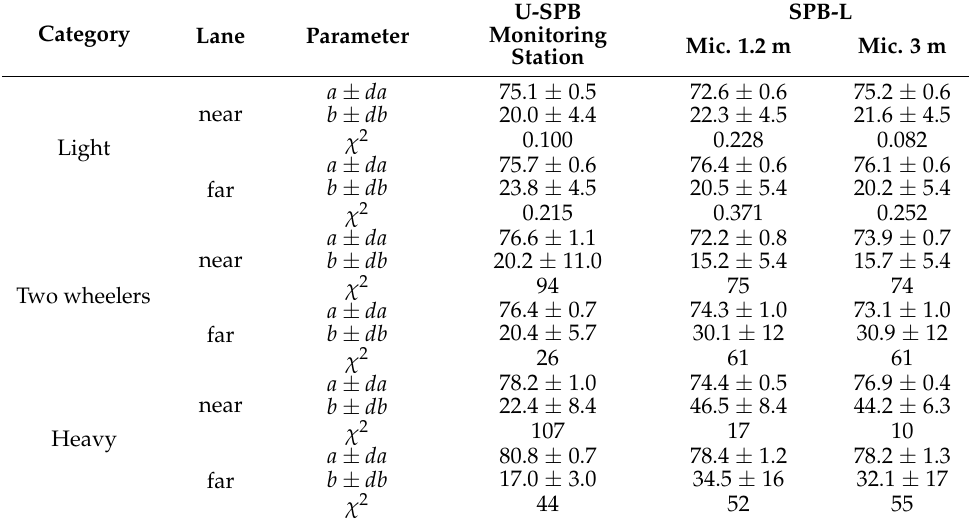
Table 5. SEL fits comparison for night U-SPB and SPB in T1. a and b units are dB(A).